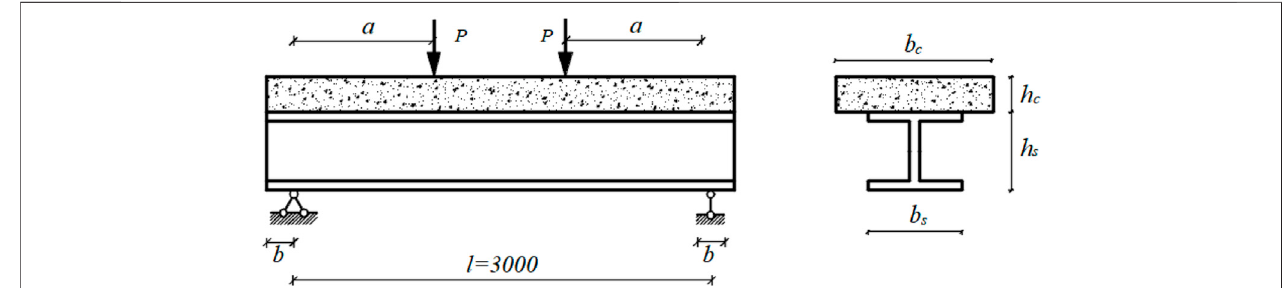
FIGURE 2 | Test specimen of the composite beam, Beam